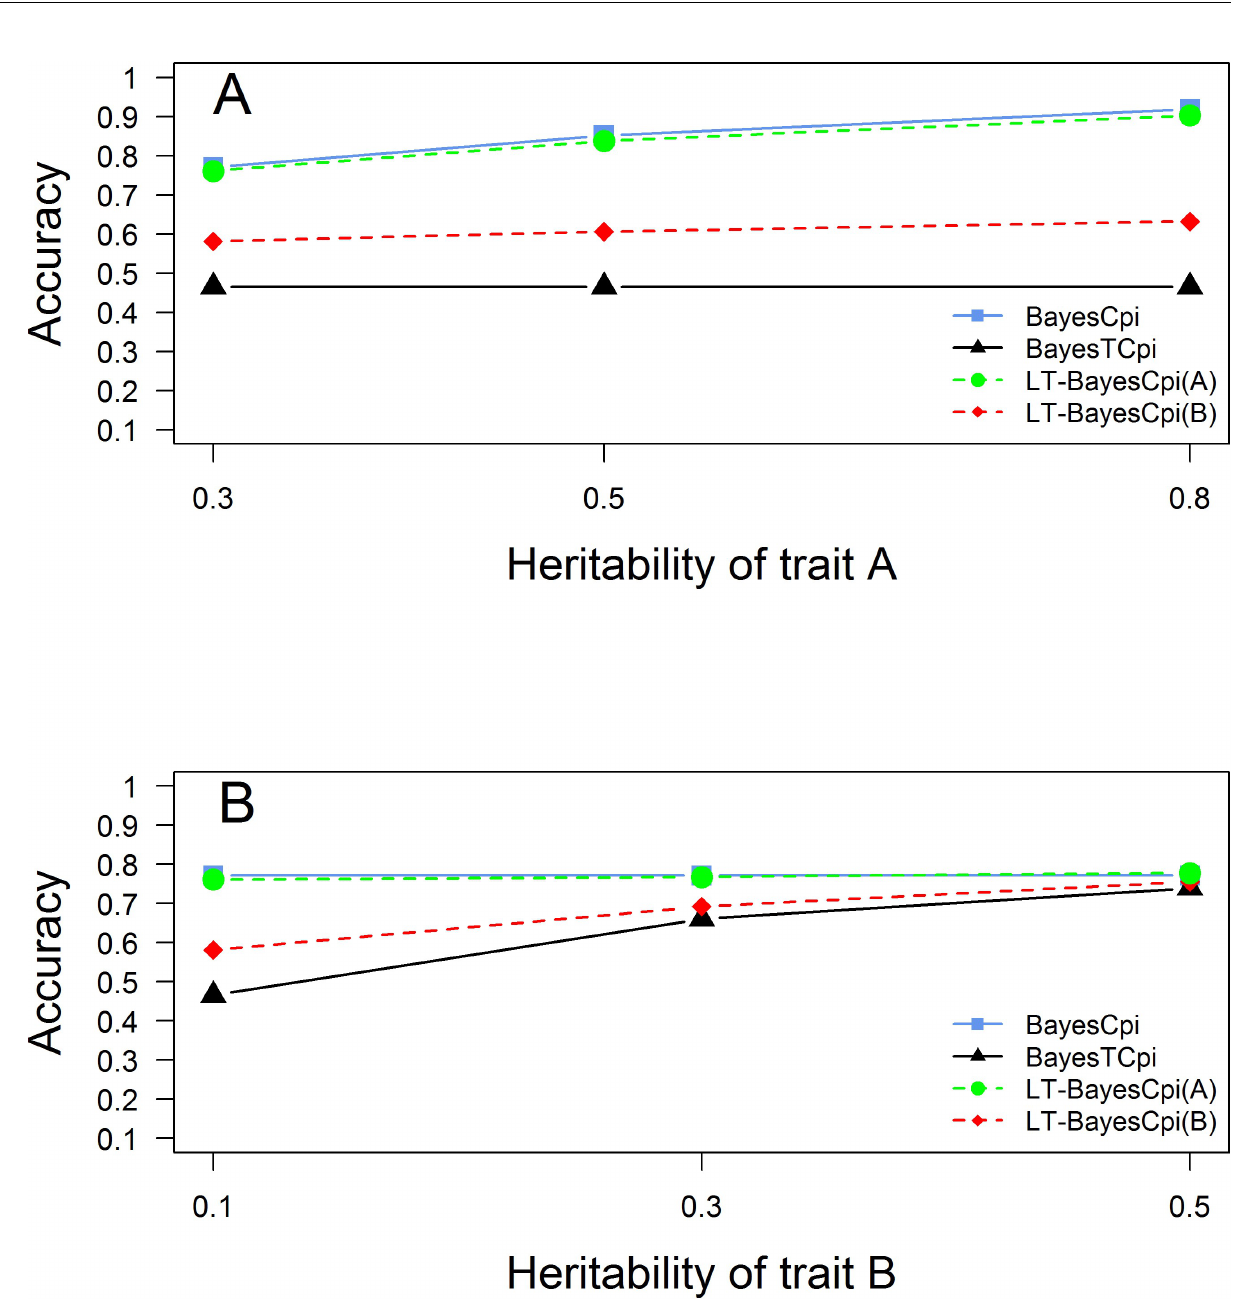
Fig 3. Accuracies of GEBVs from three methods in generation 3 with different heritabilities. A: heritabilityof the continuous trait A changingfrom 0.3 to 0.8, while keepingthe heritabilityof the binary thresholdtrait constant (0.1); B: heritabilityof the binarythresholdtrait B changingfrom 0.1 to 0.5, while keepingthe heritabilityof the continuoustrait constant